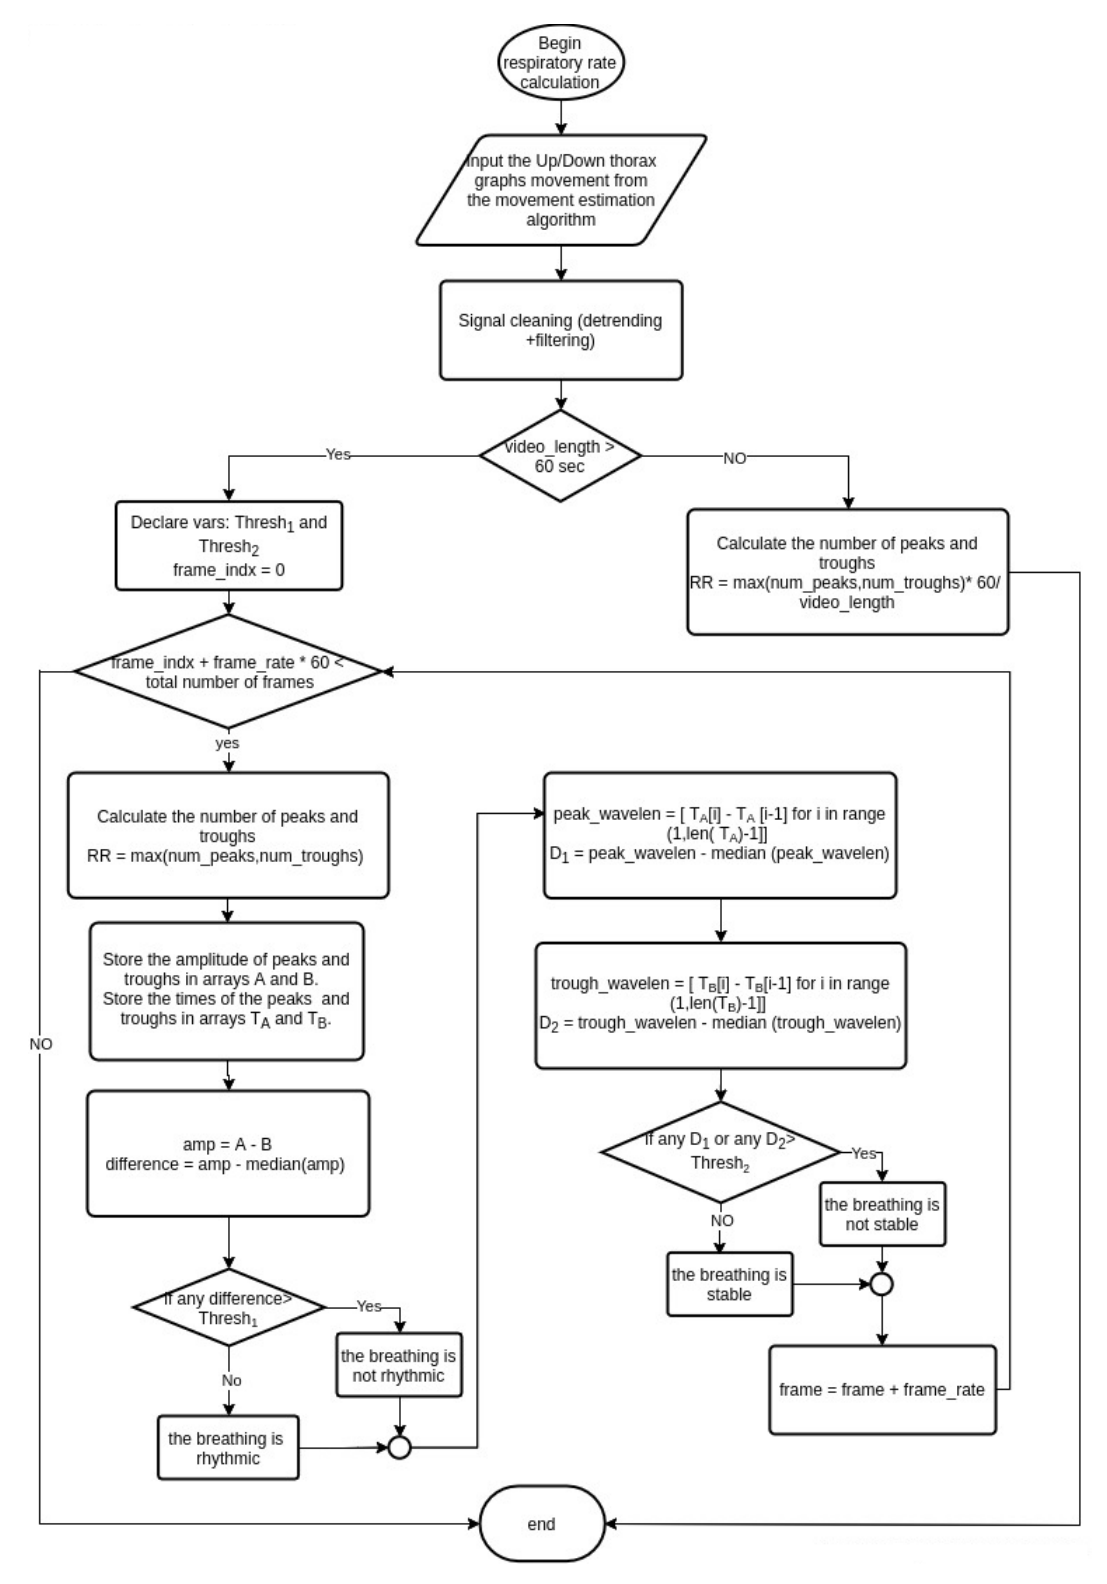
Figure 6. Breathing analysis